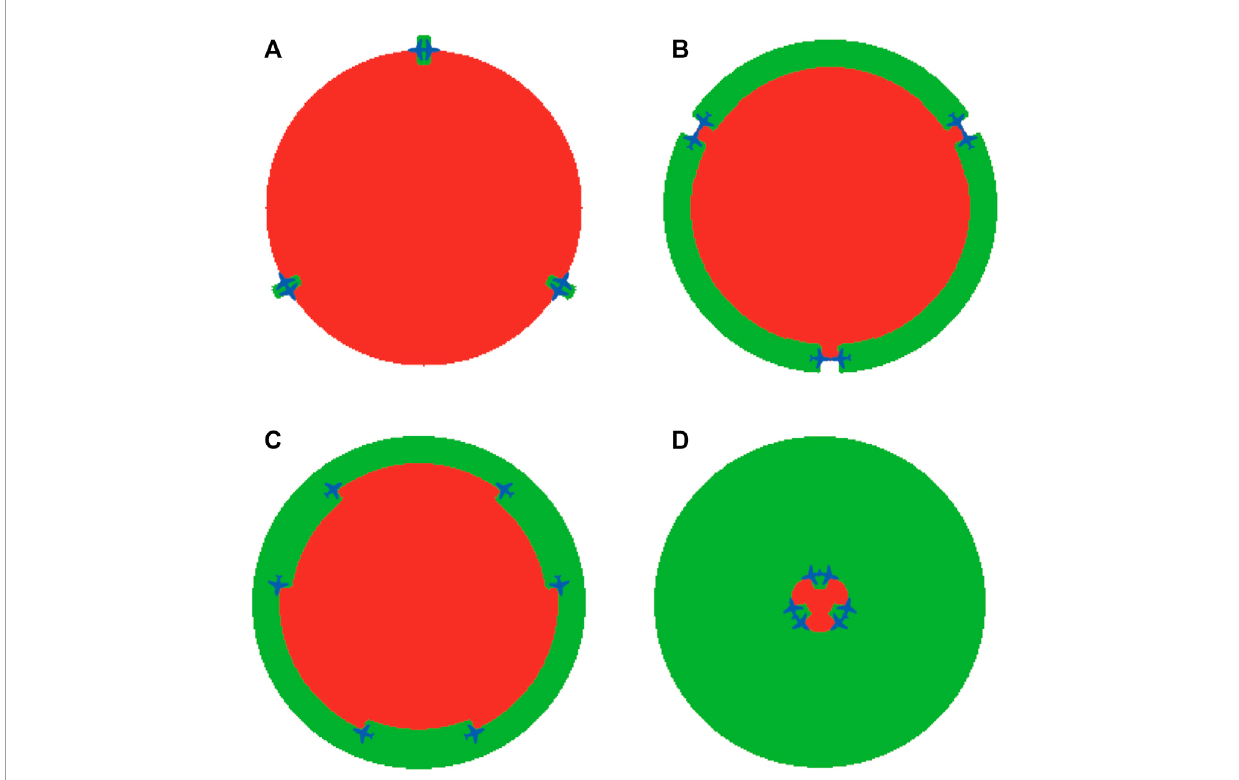
FIGURE 3 Swept areas and evader region status for different times in a scenario where 6 agents employ the circular pincer sweep process. (A) —Beginning of first cycle. (B) —Toward the completion of the first cycle. (C) —Beginning of the second cycle. (D) —Beginning of the one before last cycle. Green areas are locations that are free from evaders and red areas indicate locations where potential evaders may still be located.